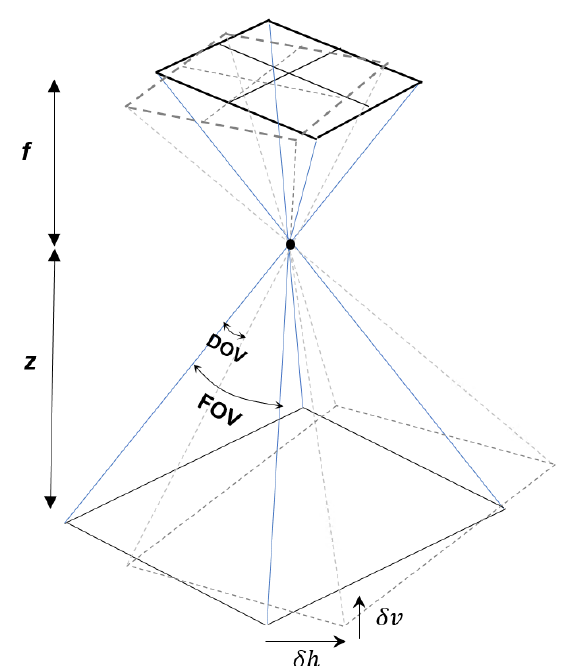
Figure 2. DOV effect on horizontal and vertical